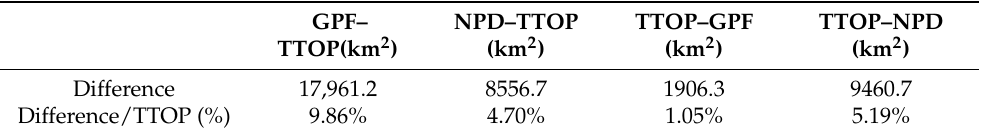
Table 1. Comparisons of permafrost area in this study and three published permafrost maps in the Qilian